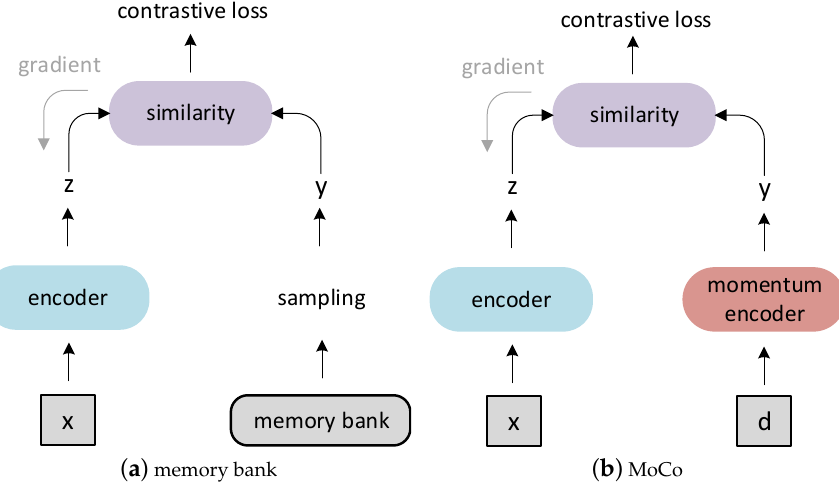
Figure 3. Comparison between memory bank [15] and MoCo [19]. ( a ) Forming a memory bank and sample from it as the key representations; ( b ) MoCo encodes the dictionary on-the-fly by momentum updating an encoder